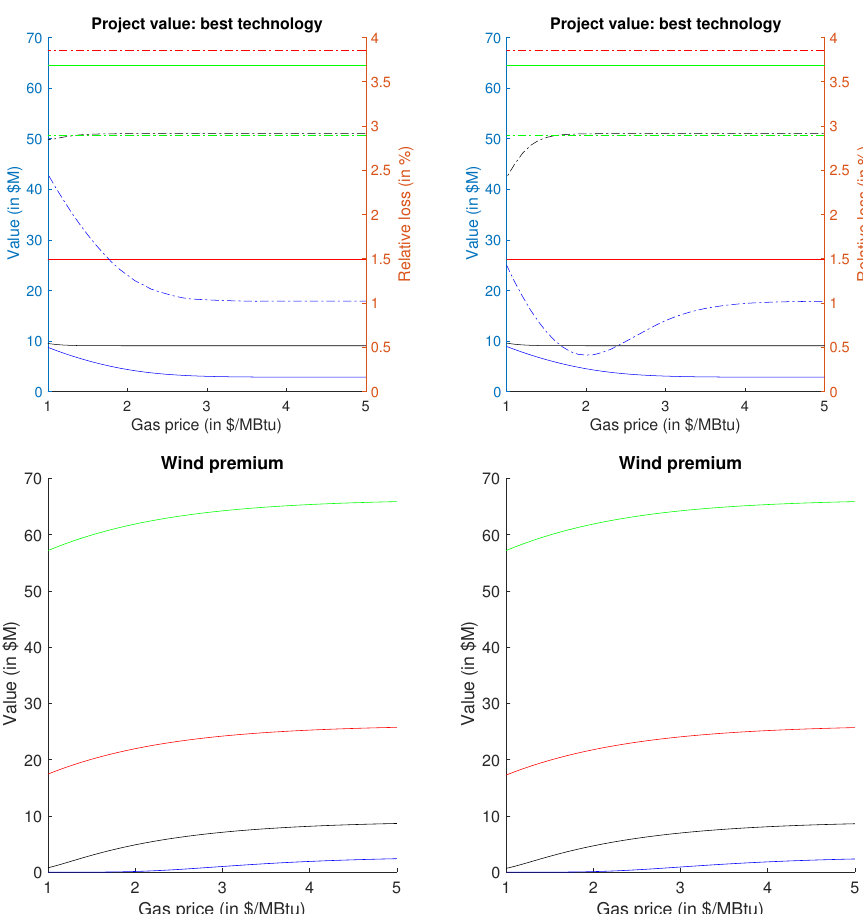
Figure 14. This figure displays the effects of the subsidy rate s on the project value (left scale, upper panels) and wind premium (lower panels) at t = 0 in case of low sensitivity of the gas price ( C = 0, left panels) and of high sensitivity ( C = 2.5, right panels). Dot-dashed lines in middle panels correspond to the relative loss with respect to the no-pandemic case (right scale). The values of s are: s = 0 (blue), s = 10 (black), s = 20 (red), s = 30 (green). The value of X 0 is 50$/MWh. Other parameter values are given in Table 1; the investment horizon is T = 1